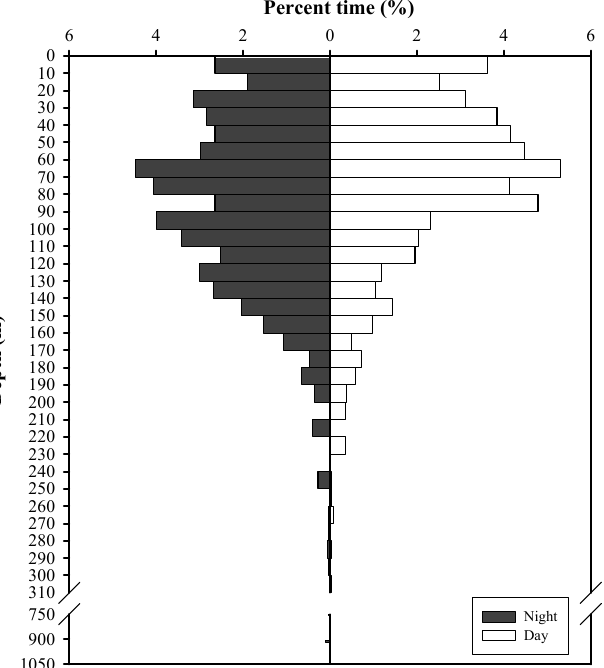
Fig. 3. Percentage of time spent in different depth for 7 tagged yellow fi n tuna in a total of 189 days. □ : Nighttime and ■ : daytime.